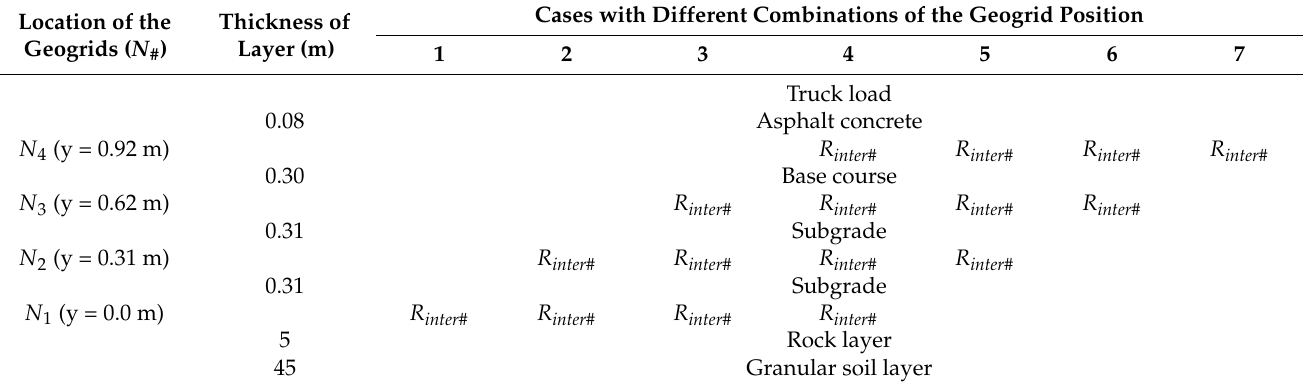
Table 2. Description of the geogrid locations, thickness of the layers of the road structure and the cases analyzed taking into account the R inter# = 1.0, 0.8 and 0.67, in the numerical modeling. Location of